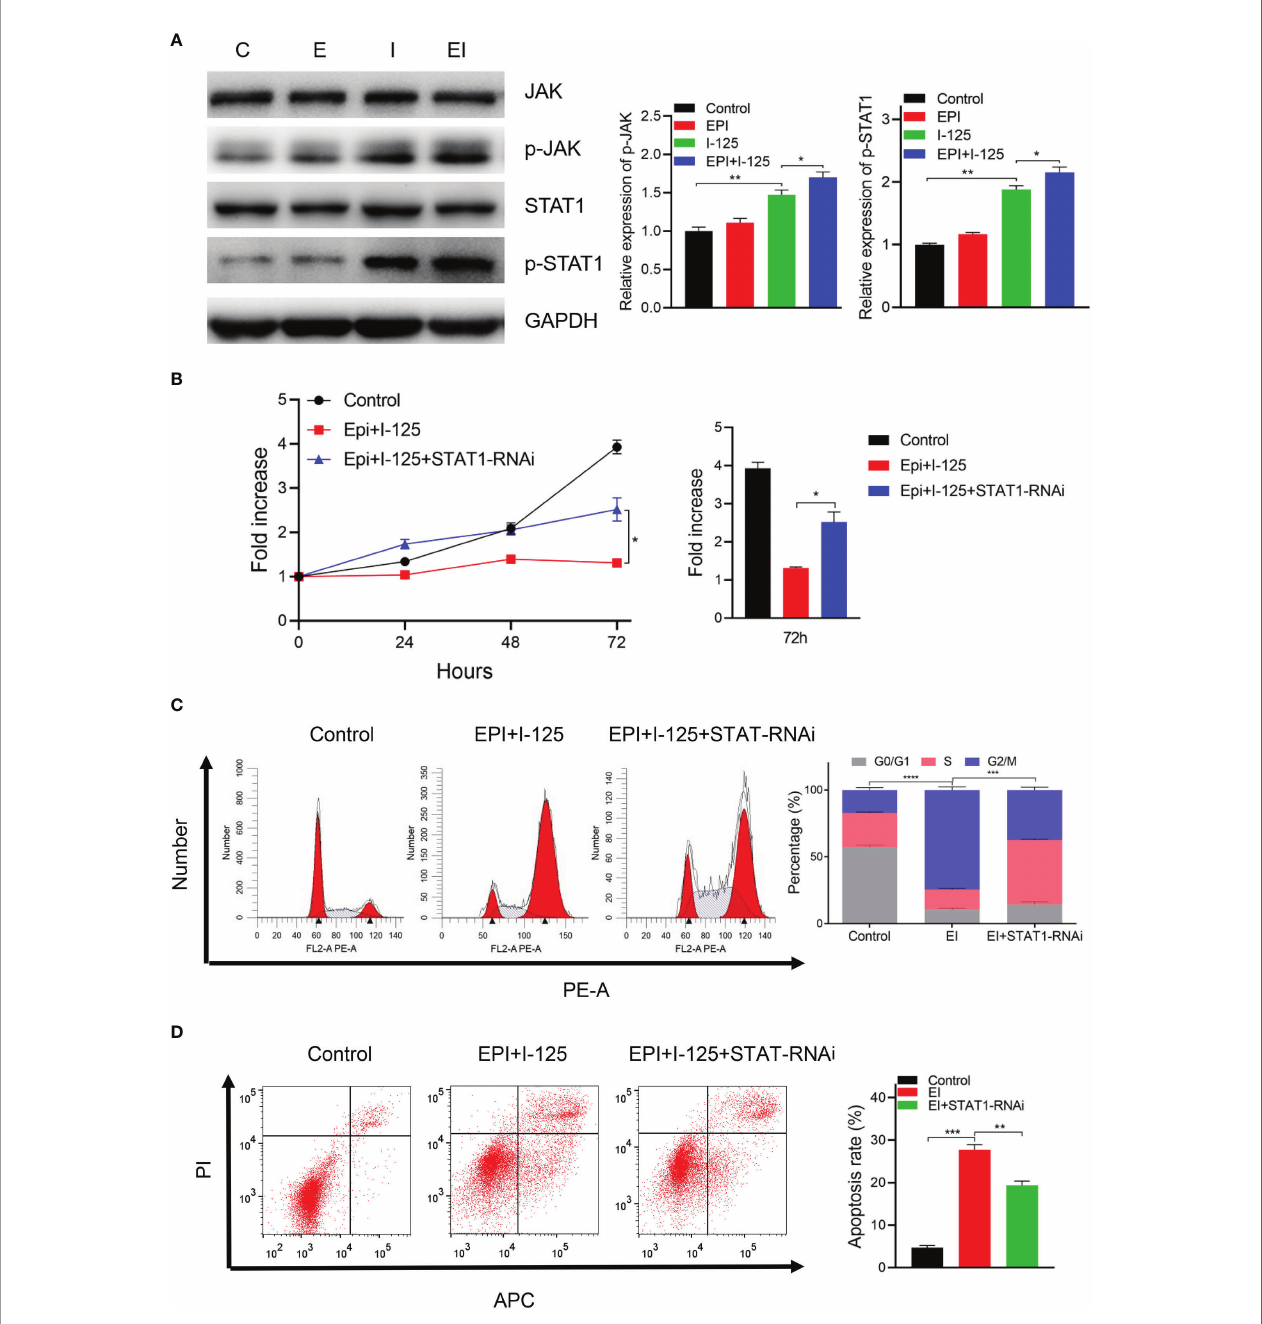
FIGURE 5 | EPI increased the anti-cancer effects of 125 I via the JAK/STAT1 pathway. (A) Western blot showing the expression of JAK/STAT1 signaling. (B) CCK-8 showing cell proliferation ability. (C, D) Flow cytometry results showing the effects on cell cycle (C) and apoptosis (D) . All the experiments were performed in triplicate, and the data are presented as the mean ± SD. * P < 0.05, ** P < 0.01, *** P < 0.001, **** P < 0.0001. EPI, epirubicin; CCK-8, cell counting